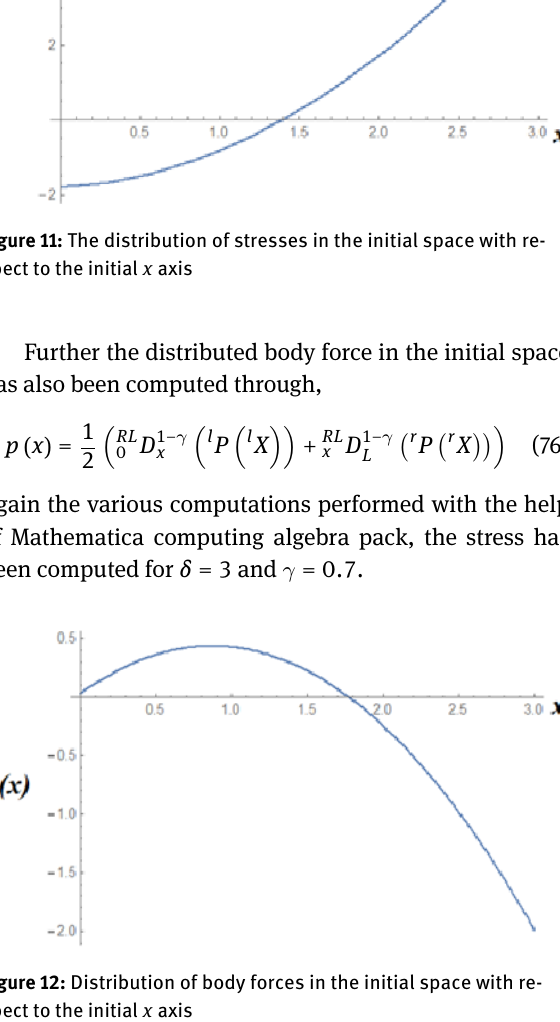
Figure 12: Distribution of body forces in the initial space with re- spect to the initial x